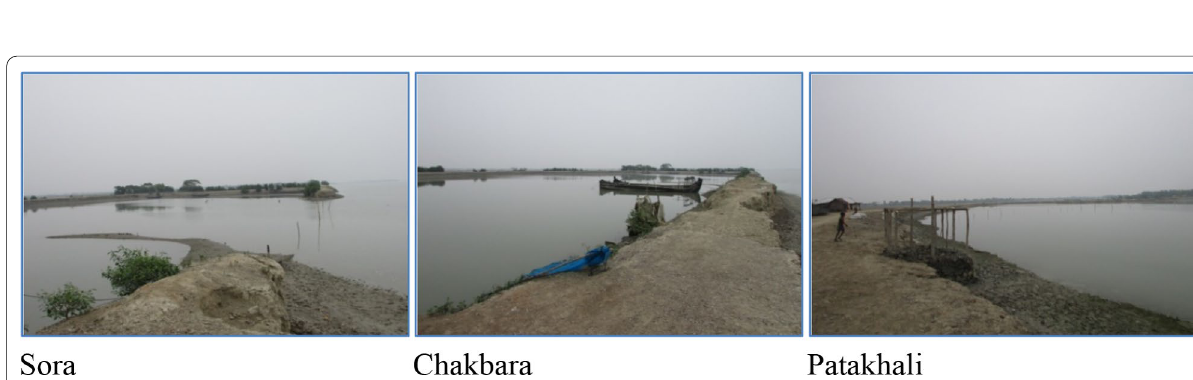
Fig. 5 Damaged embankment by the cyclone Aila of the study